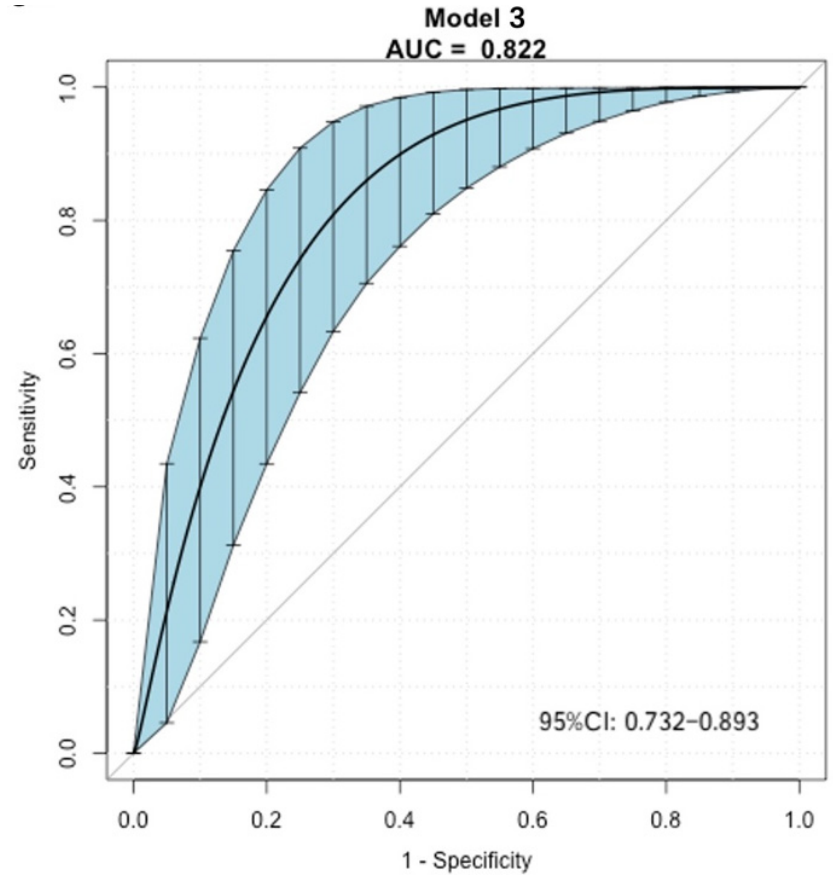
Figure 4. The ROC curve for the nomogram 3 using bootstrap resampling (times = 500). Shading shows the bootstrap estimated 95% CI with the AUC. ROC, receiver operating characteristic; AUC, area under the curve; CI, confidence interval.